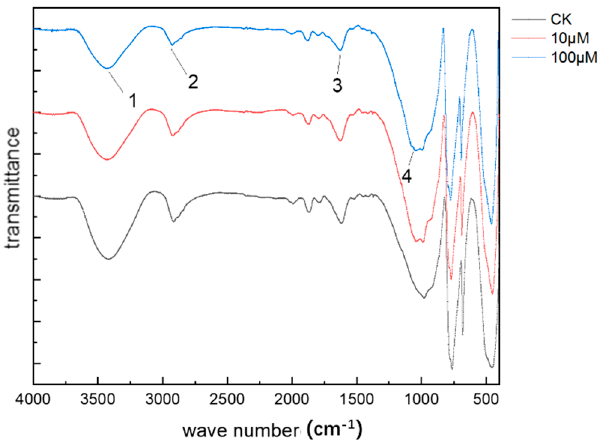
Figure 6. The FTIR spectra of cell wall components of roots after 40 days of cultivation.